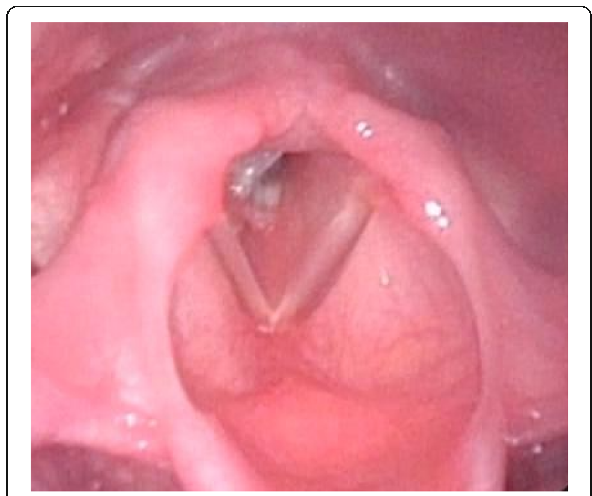
Fig. 2 A laryngoscopic image that was thought to be severe edema at the subglottic stenosis on